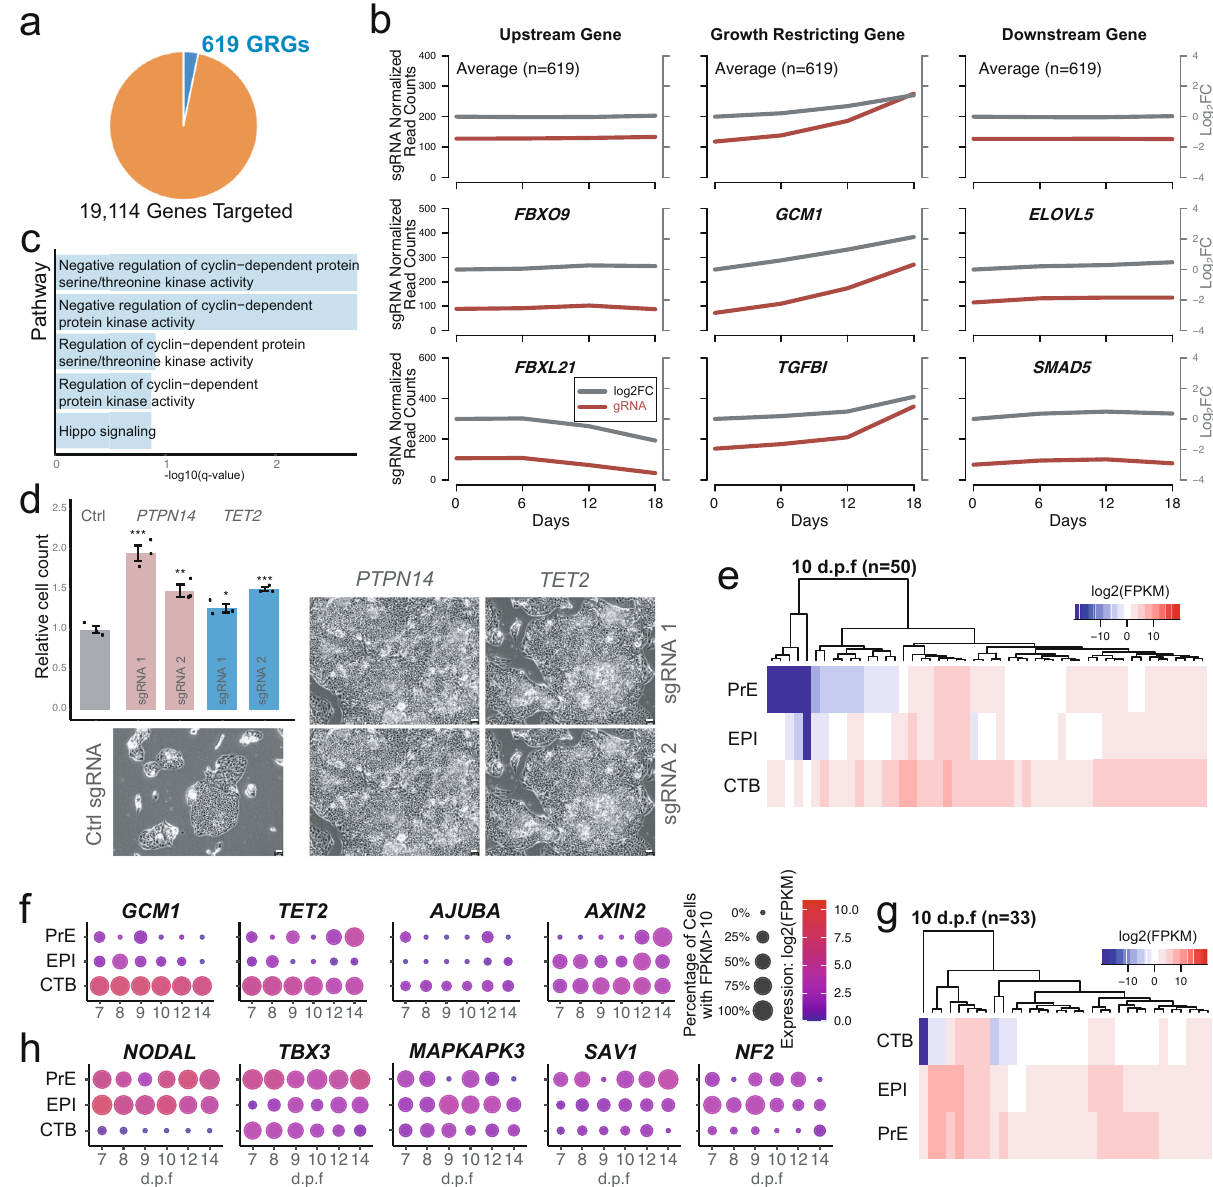
Fig. 5 Identi fi cation and characterization of hTSC GRGs. a Growth-restricting genes (GRGs) identi fi ed among all targeted genes. b The mean of sgRNA normalized read counts and Log2 fold changes of all or selected hTSC GRGs and their neighboring up- and downstream genes over time. The results are representative of two independently transduced screening experiments. c Top 5 most enriched GO Biological Processes terms among all hTSC GRGs. d Top left, live cell counts relative to the mean of control sgRNA transduced H9 hTSCs 6 days after seeding. Error bar represents the standard error of three biological replicates. Two-tailed student ’ s t test was used for statistical analysis. “ * ” indicates a p -value < 0.05, “ ** ” indicates a p -value < 0.01, and “ *** ” indicates a p -value < 0.001. The exact p-values from left to right are 0.000870208, 0.005413584, 0.018757677, and 0.000646371. Rest of the panel, phase contrast images of H9 naïve hTSCs transduced with control or targeting sgRNAs at 6 days following seeding. The scale bars indicate 75 μ m. The images are representative of three independent replicates in an experiment. e Heatmap showing the expression of 50 CTB-enriched GRGs in the CTB, EPI, and PrE of published 10 d.p.f. human embryo scRNA-seq data 37 . f Dot plot showing the expression of selected CTB-enriched GRGs in the CTB, EPI, and PrE of published human embryo scRNA-seq data 37 . g Heatmap showing the expression of 33 CTB-depleted GRGs in the CTB, EPI, and PrE of published 10 d.p.f. human embryo scRNA-seq data 37 . h Dot plot showing the expression of selected CTB-depleted GRGs in the CTB, EPI, and PrE of published human embryo scRNA-seq data 37